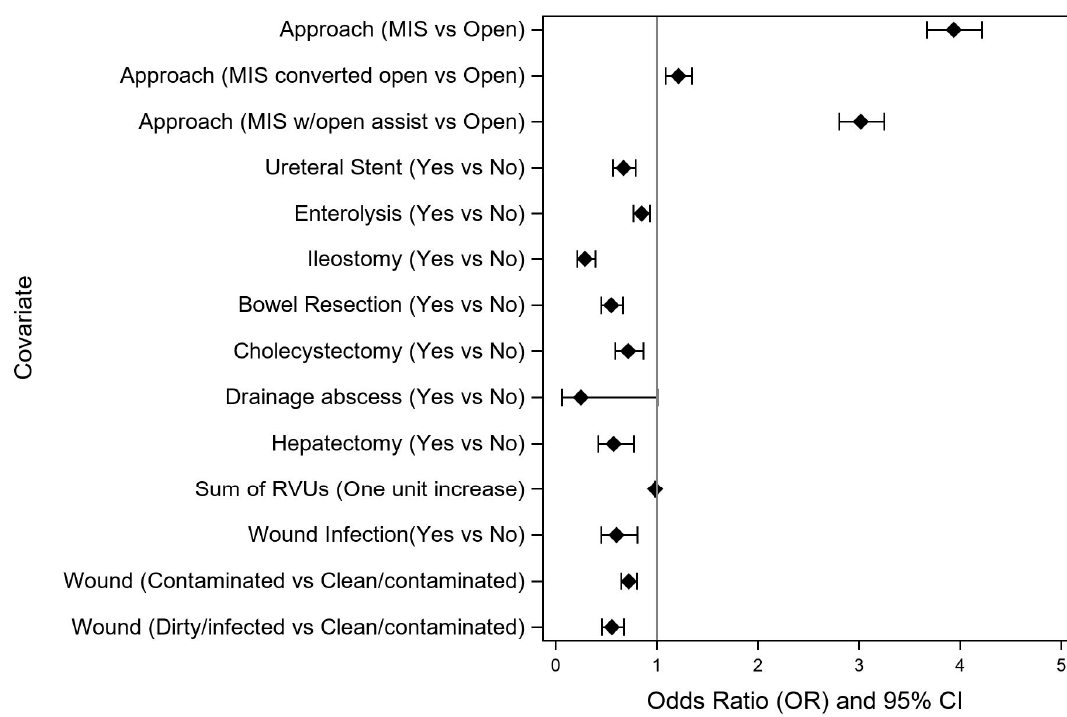
Figure 3. Impact of intraoperative factors on likelihood of early discharge (odds ratio > 1) after non-emergent right colectomy for colon cancer. MIS, minimally-invasive surgery; RVU, relative value unit.